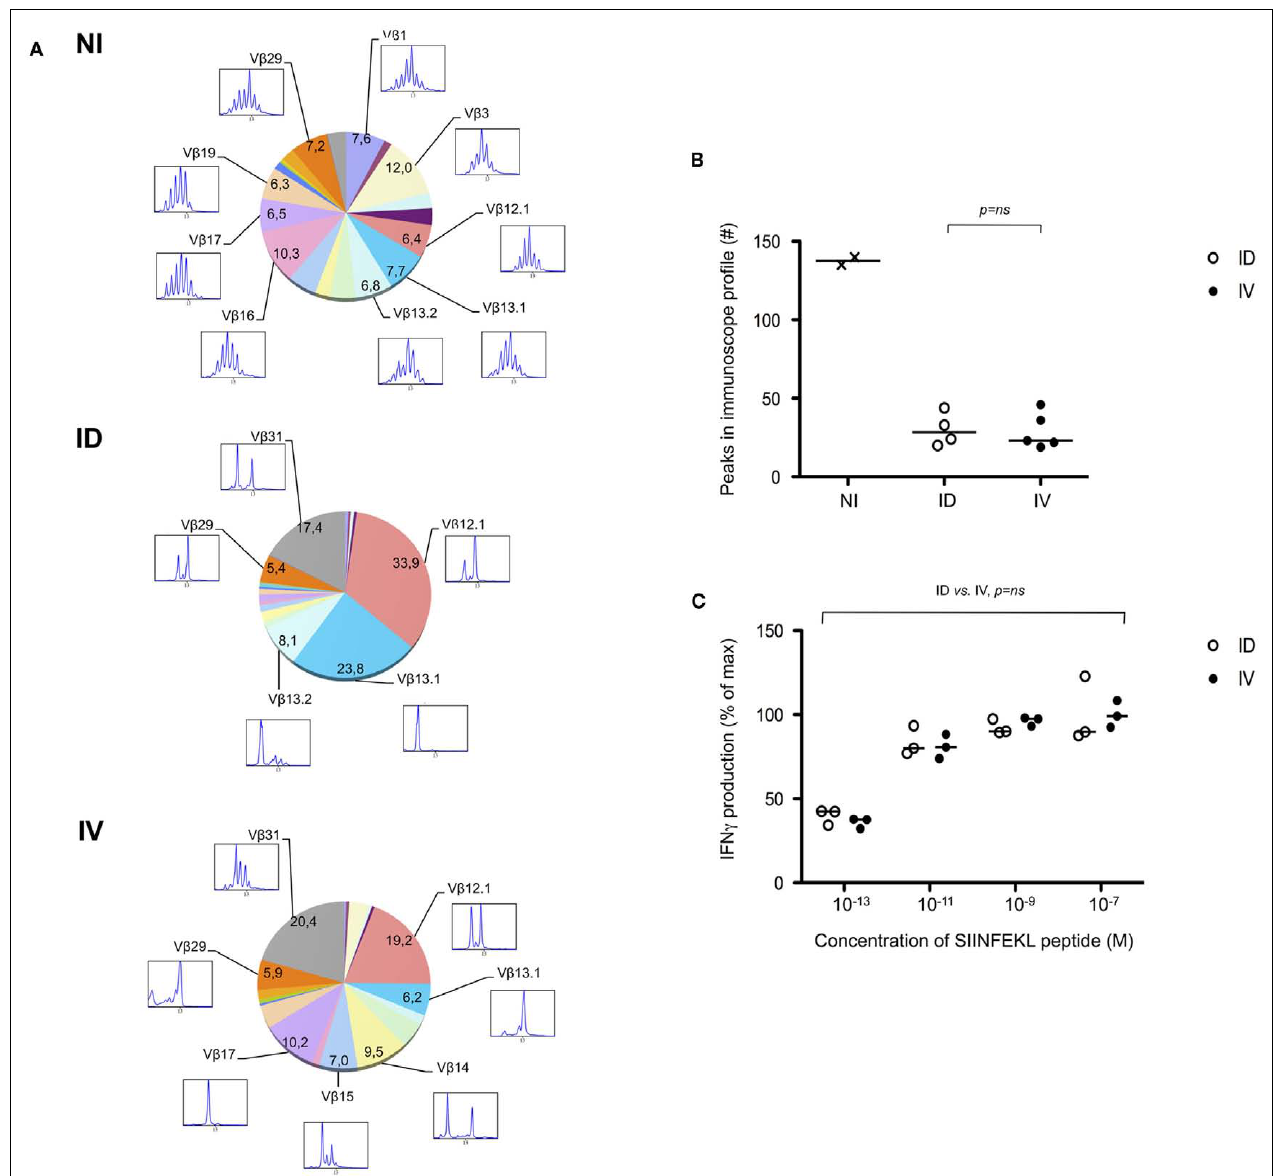
represented. Data points indicate a single mouse.V β family representation for each animal is shown in FigureA2 in Appendix. Statistical analysis comparing ID and IV was assessed by Mann–Whitney U -test and p -values are shown. NI, non-immunized mice, and is shown to indicate baseline diversity ofTCR. (C) To assess functional avidity of the respondingT cells, the draining lymph node and spleen of five mice were pooled, day 8 post-immunization. CD8 + T cells were purified and analyzed by IFN γ ELISPOT. SIINFEKL peptide pulsed DCs were used to re-stimulate CD8 + T cells. SIINFEKL peptide concentrations are indicated. Results are represented as the percentage of maximal IFN γ production. Data points indicate a replicates for each condition. Results are representative of two independent experiments. Percentage of maximum IFN- γ production was analyzed using peptide concentration as a continuous variable (general linear